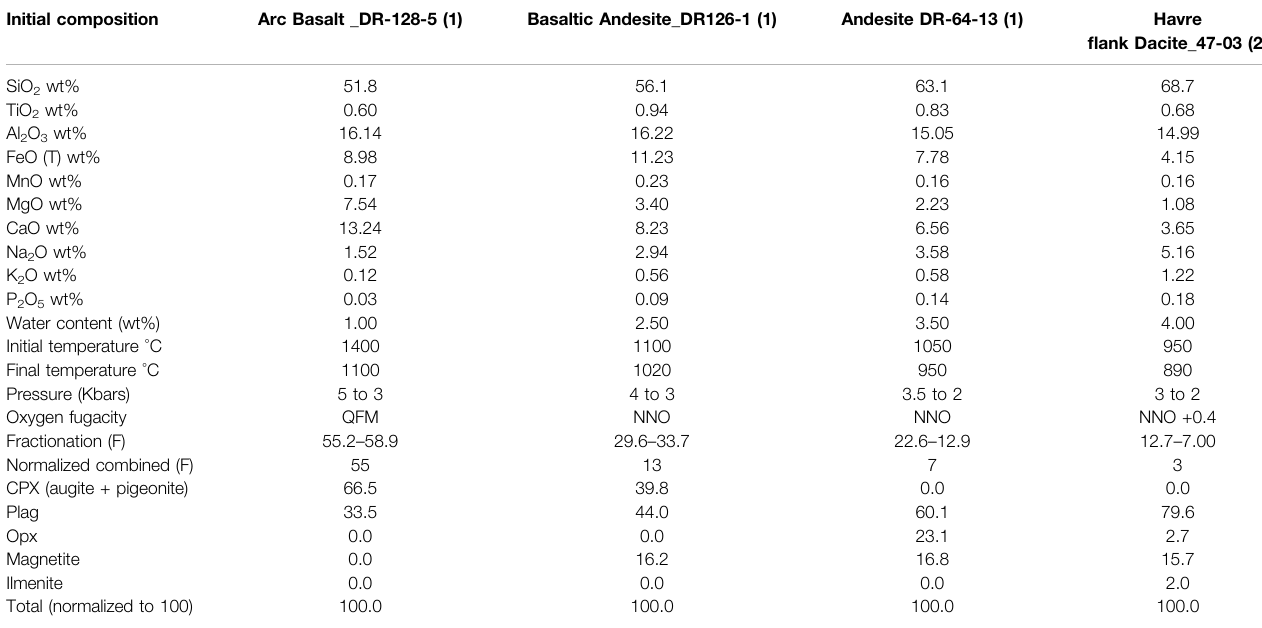
TABLE 3 | Initial compositions and conditions of Rhyolite-MELTS models and resulting proportion of mineral phases fractionated normalized to 100 for use in trace element models. CPX, OPX, and plag are abbreviated for clinopyroxene, orthopyroxene and plagioclase, respectively. Initial composition Arc Basalt _DR-128-5 (1) Basaltic Andesite_DR126-1